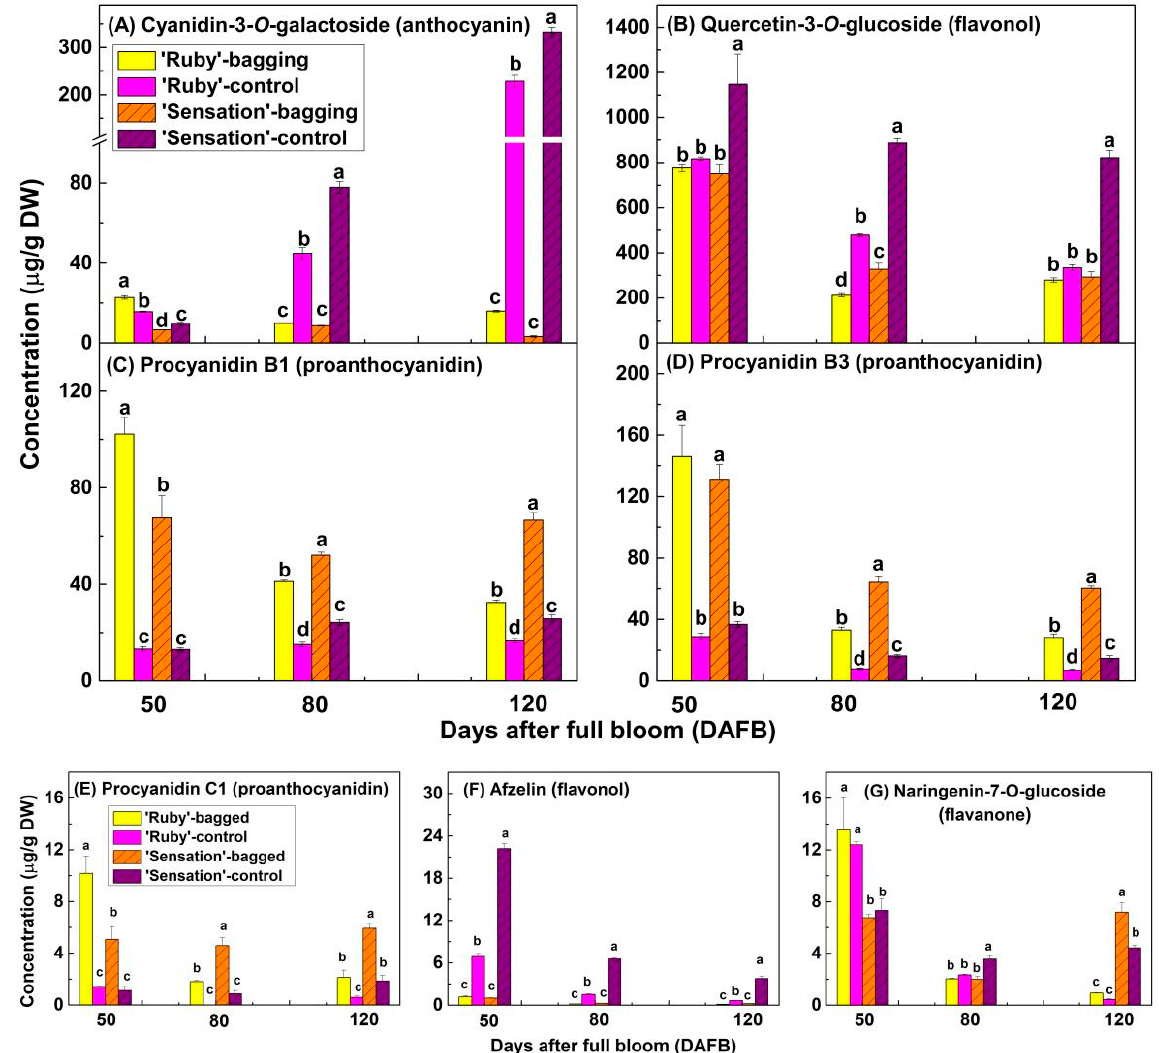
Figure 2. Concentration of main ( A – D ) and minor ( E – G ) flavonoid compounds detected in the fruit skin of bagged and control (non-bagged) ‘Ruby’ and ‘Sensation’ mango during different developmental stages. Each value represents the mean ± standard deviation of three biological replicates. Mean values were compared within the same day after full bloom, and values with the same letter are not significant-ly different, p > 0.05 according to Tukey